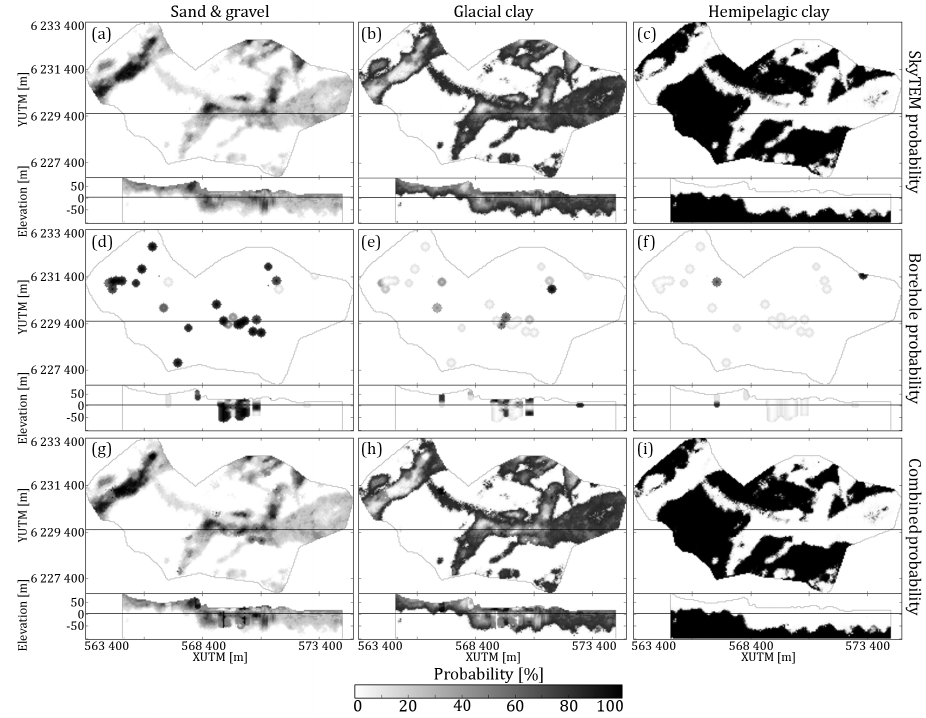
Figure 8. A visual representation of the tau model procedure for combining the soft resistivity and borehole grids. Each grid is portrayed as a horizontal slice at 20mb.s.l. and a vertical cross section intersecting at YUTM 6230100m. (a–c) show the sand and gravel, glacial clay, and hemipelagic clay probability maps, respectively, for one DS reconstructed resistivity grid; d–f show the 200m radius kriged borehole probability; and (g–i) show the combined resistivity grid, which has been combined using a tau model with the values [ τ r ,τ b ] = [2,